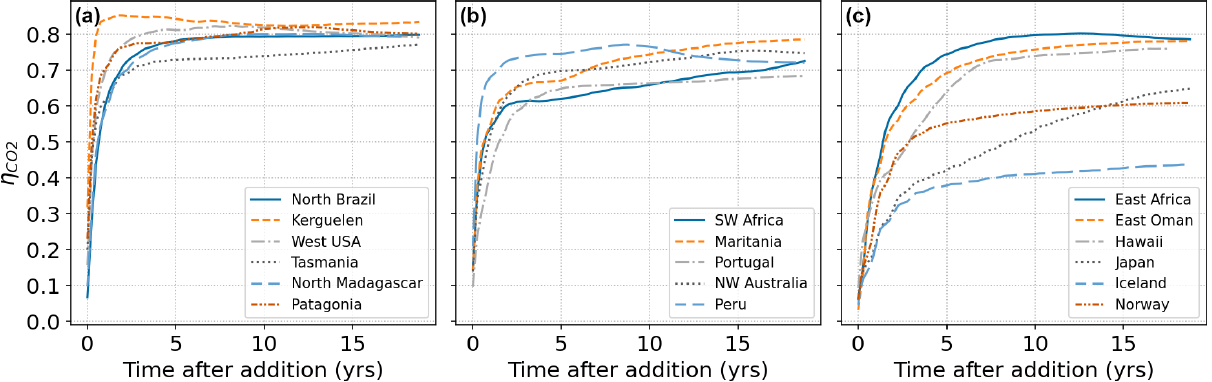
= (cid:49) DIC /(cid:49) Alk) following pulse additions at 17 different locations. Figure 5. CO 2 uptake relative to alkalinity addition (molar ratio η CO 2 (a) Locations which equilibrate fast and reach close to the theoretical maximum of CO 2 uptake ( ∼ 0 . 8). (b) Locations which equilibrate fast but reach a lower plateau of relative CO 2 absorption (0.6–0.8) with slow further progression. (c) Locations with slow equilibration or significant loss of alkalinity to the deep. Note that in some cases despite the slower initial equilibration high uptake ratios can be eventually